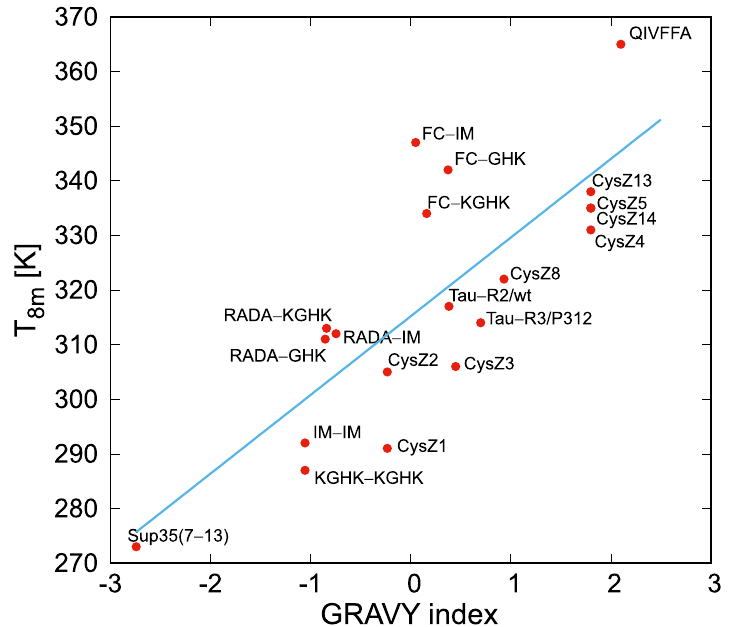
Figure 4. Plot of the correlation between the GRAVY indices and the half − point octamer − melting temperatures of the peptides studied. The correlation equation is T 8 m = 14.4 × GRAVY + 315. The correlation coefficient and standard deviation in T 8 m are R = 0.7946 and σ T The graph was drawn with gnuplot